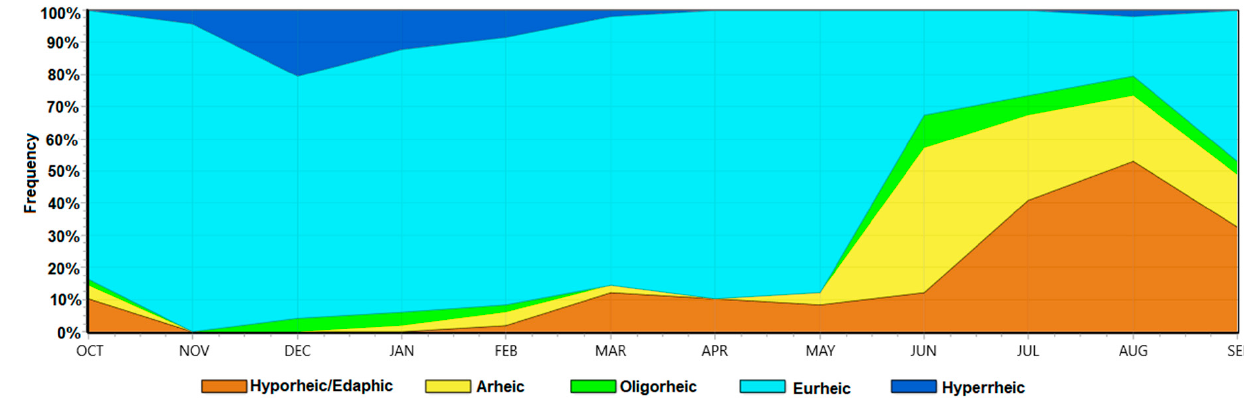
Figure 13. ASFG of the natural state of Tsiknias River derived from flow simulations (1955–2005).